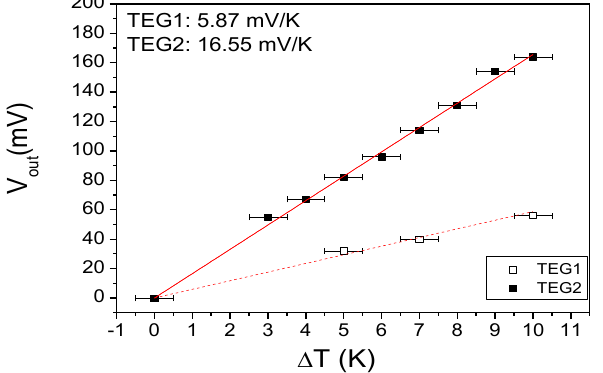
Figure 5. Output voltage ( V ) as a function of the macroscopic temperature difference out across the device ( ΔT ) for TEG1 and TEG2. The red lines represent linear fits to the experimental